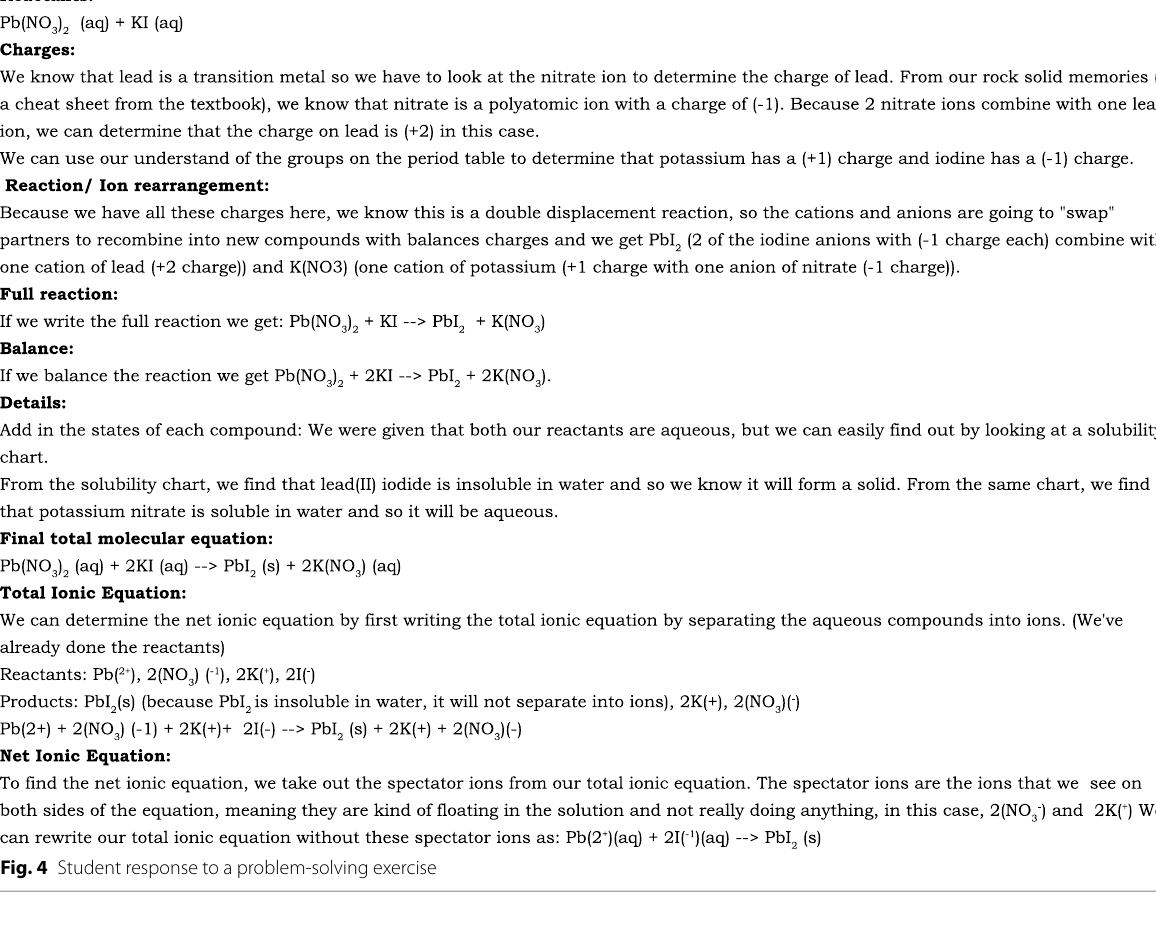
Fig. 4 Student response to a problem-solving